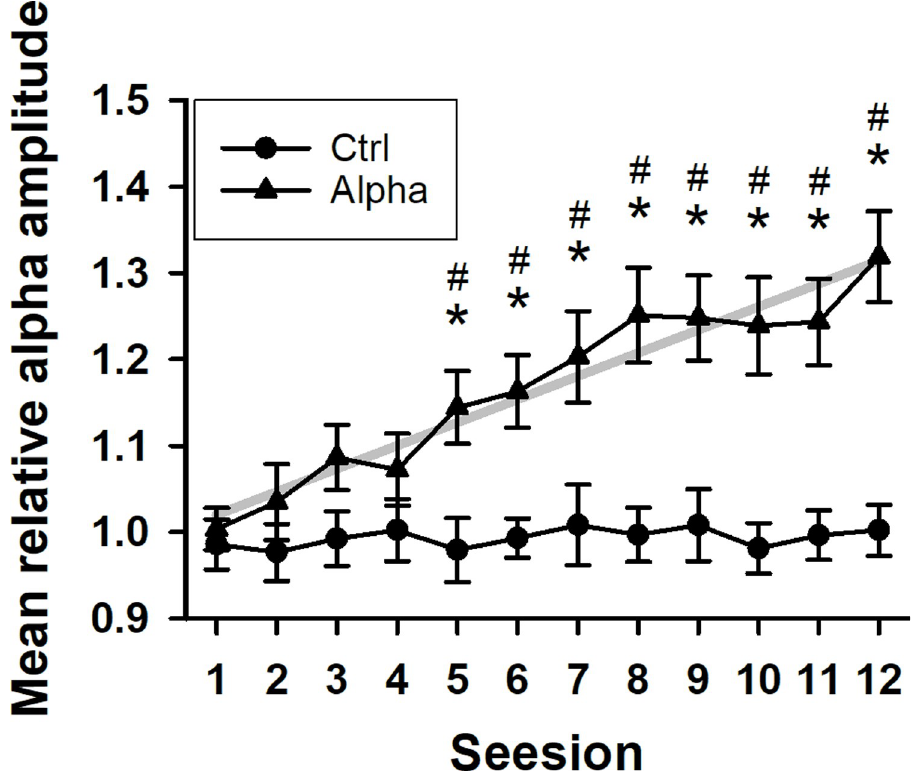
Fig 1. Mean relative alpha amplitude changes throughout the 12 sessions in two groups. The gray line is the linear regression line and indicates a progressive linear increase in the Alpha group. � p < 0.05 vs. the 1st session. # p < 0.05 vs. the Ctrl